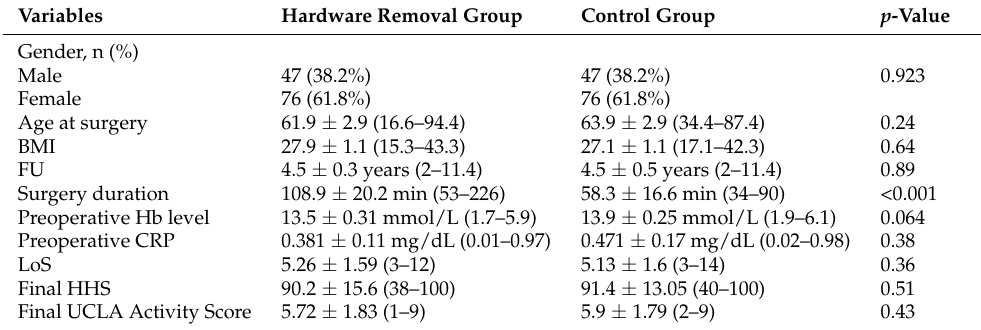
Table 1. Demographic